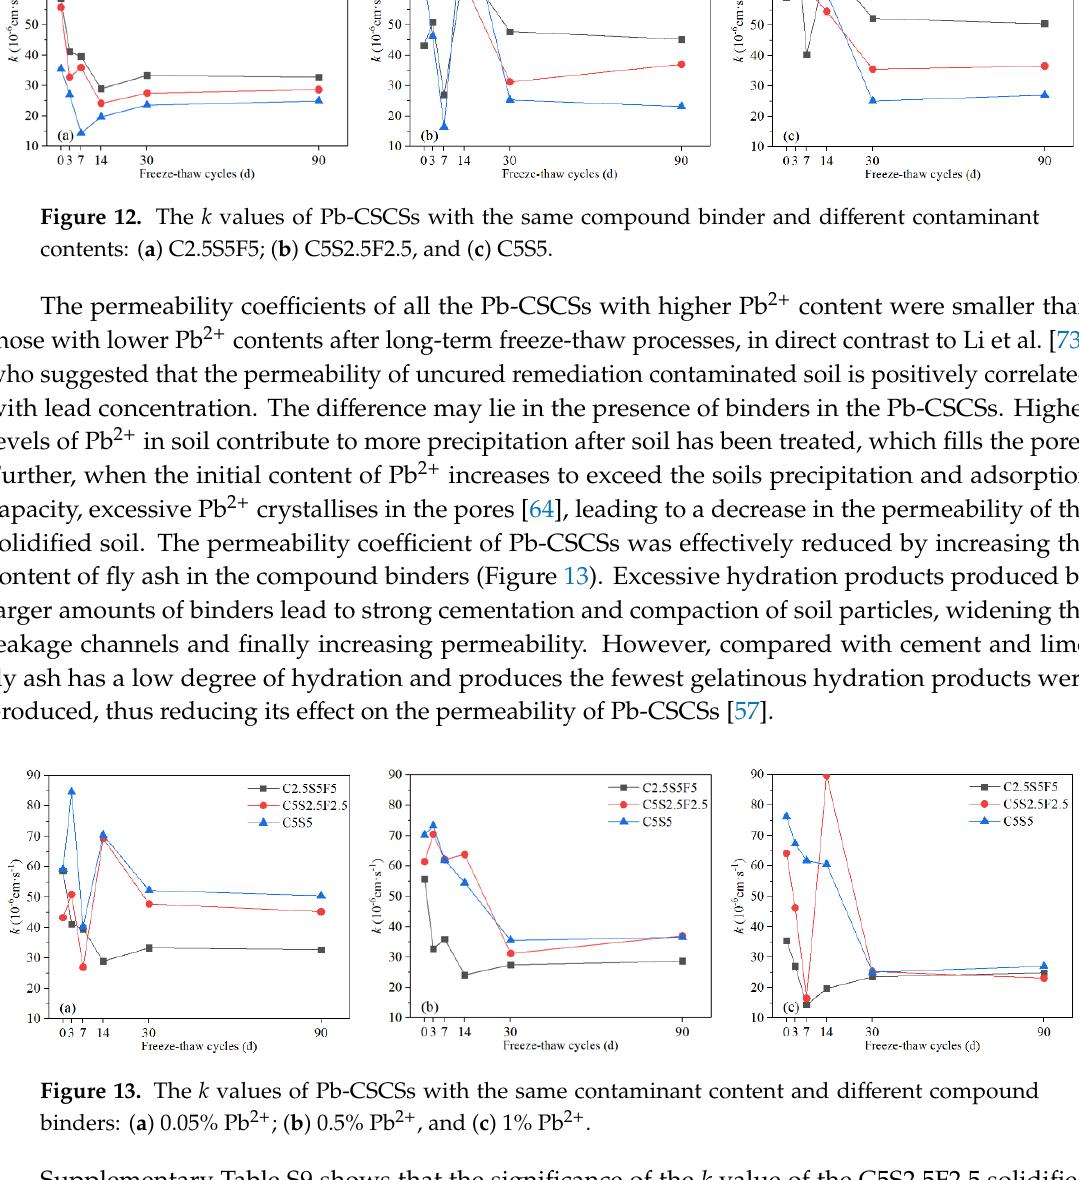
Figure 13. The k values of Pb-CSCSs with the same contaminant content and different compound binders: ( a ) 0.05% Pb 2+ ; ( b ) 0.5% Pb 2+ , and ( c ) 1% Pb 2+ .